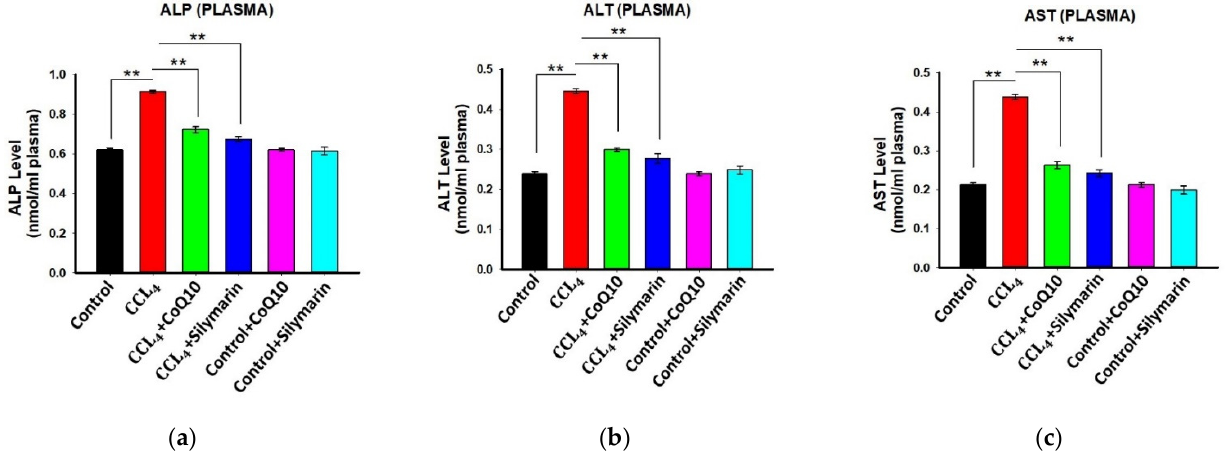
Figure 4. Effect of CoQ10 and silymarin on ALP ( a ), ALT ( b ) and AST ( c ) levels in plasma of ovariectomized female rats. Data are presented as mean ± SD (n = 6). Statistical analysis involved post-hoc tests. Statistical significance is indicated as * p ≤ 0.05 and ** p ≤ 0.01.